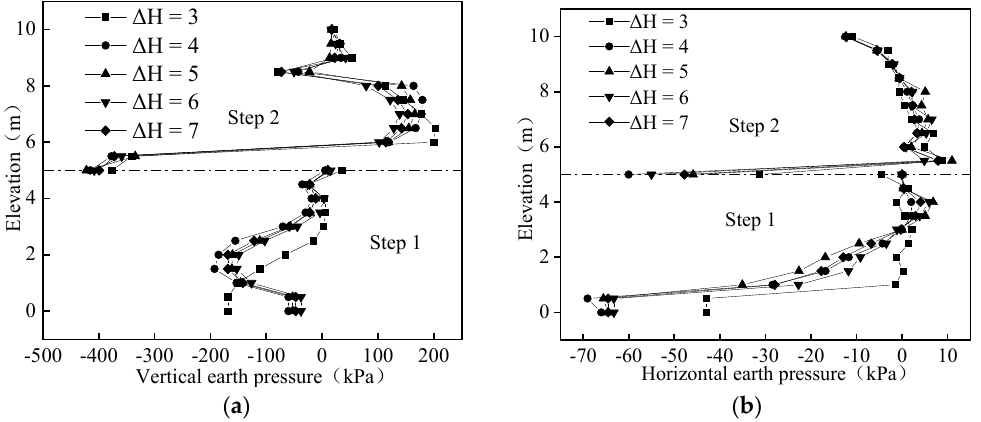
Δ : ( a ) vertical earth pressure; ( b ) hori-